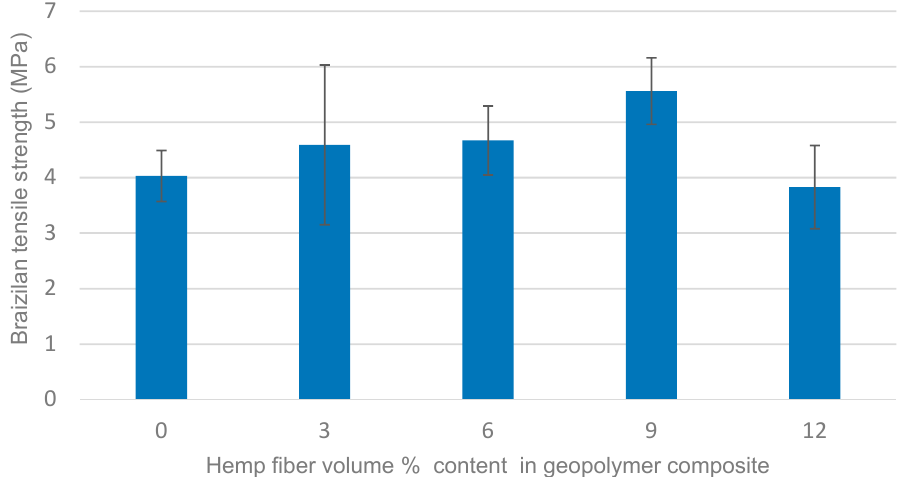
Figure 3. Effect of hemp fiber content on Brazilian tensile strength of geopolymer composites.